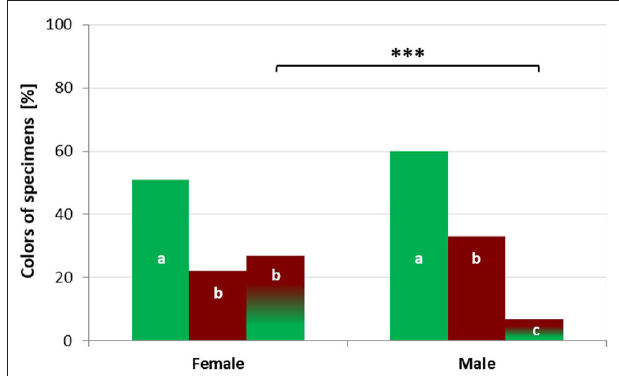
FIGURE 3 | Percentage of different color morphs in female and male Harpalus affinis ; significant color differences between sexes are indicated by stars (*** p < 0.001); significant differences between color morphs within a sex are indicated by differing